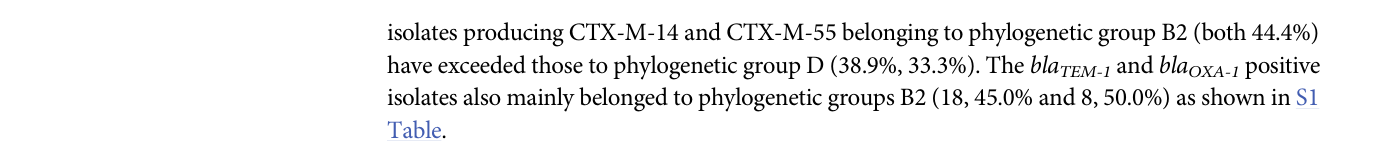
and bla positive TEM-1 OXA-1